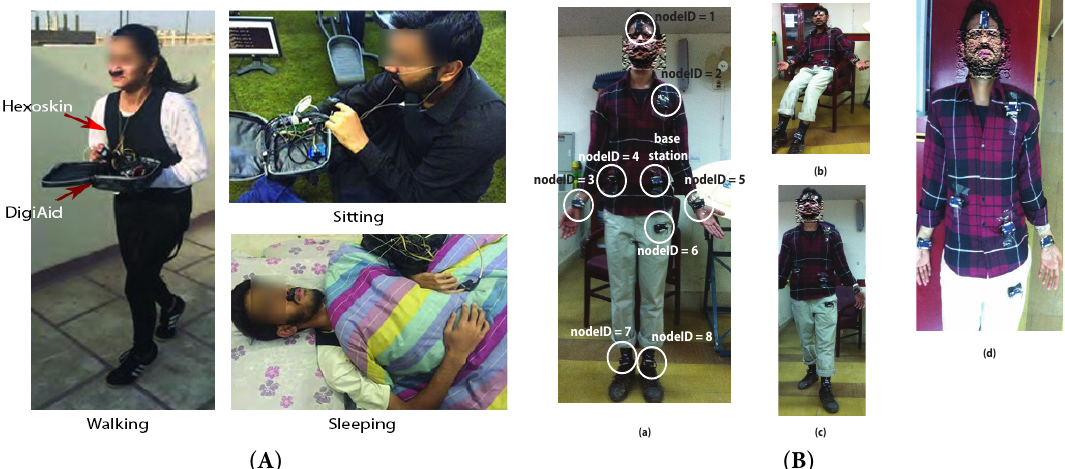
Figure 6. Positioning and movements of different subjects during experiments. ( A ) Wired DigiAID and Hexoskin; ( B ) Wireless DigiAID.